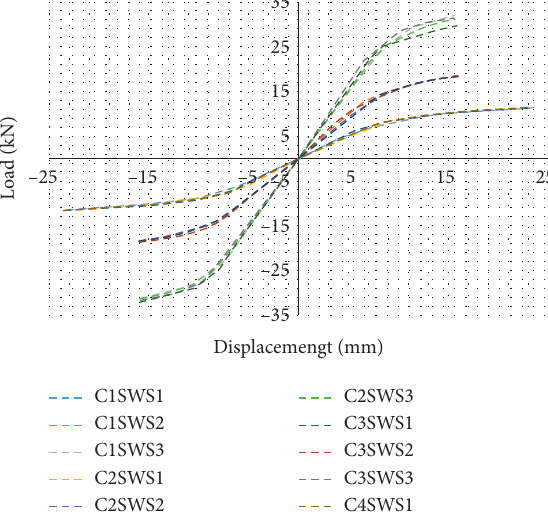
Figure 16: Comparison of load-displacement envelope curves of the model specimens. Table 12: Summary of displacement and load at yield and ultimate for different